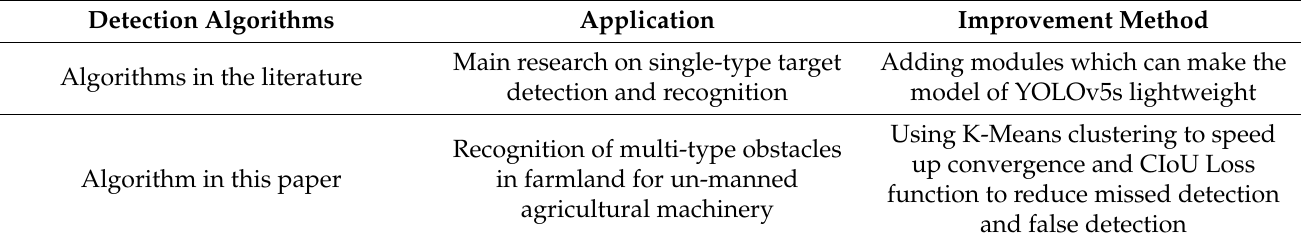
Table 1. Comparison of YOLOv5s